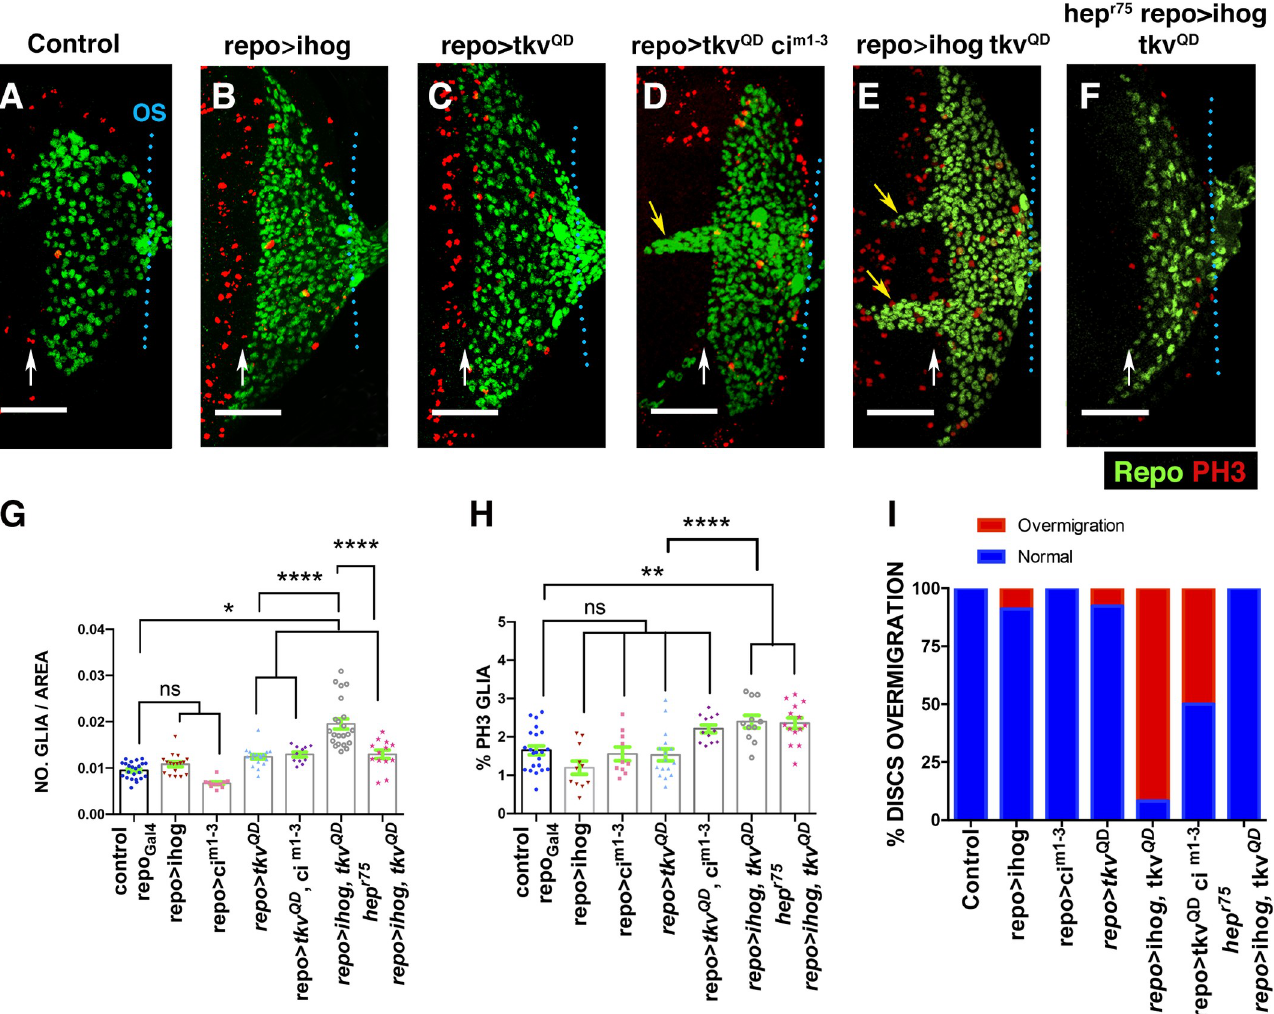
Fig 9. Overexpression of ihog and tk v QD in glial cells induces over-migration and proliferation. (A–F) Third instar eye discs stained with anti-PH3 (red) and anti-Repo (green). Basal layers of the eye disc epithelium. (A) Control tub-Gal80 ts repo-Gal4 eye disc. (B) tub-Gal80 ts / UAS-ihog; repo-Gal4 /+. (C) tub-Gal80 ts /+; repo-Gal4/UAS-tkv QD . (D) tub-Gal80 ts / UAS-tkv QD /UAS-ci m1-3 ; repo-Gal4/UAStkv QD . (E) tubGal80 ts / UAS-ihog ; repo-Gal4/UAS-tkv QD . (F) hepr75 ; tub-Gal80 ts / UAS- ihog; repo-Gal4/UAS-tkv QD . The overexpression of tkv QD under the control of repo-Gal4 increases the number of glial cells (C). The co-overexpression of UAS- tkv QD and UAS-ihog under repo-Gal4 increases the density and proliferation of subretinal glial cells and promotes the over-migration of these cells (E). The over- migration phenotype and the increase of glial density caused by the overexpression of UAS-tkv QD and UAS-ihog with repo-Gal4 was suppressed in the hep r75 mutant discs. Nonetheless, the glial cell division was not significantly altered (F and H). (G) The graph represents the glial density of discs shown in A-F. (H) Histogram showing the percentage of glial cells in mitosis (Ph3 positive) of discs indicated in A–F. (I) The graph represents the percentage of discs with glial over- migration shown in A–F. Scale bars, 50 μ m. Statistical analysis is shown in Table H in S1 Text. The numerical data used in this figure are included in S1